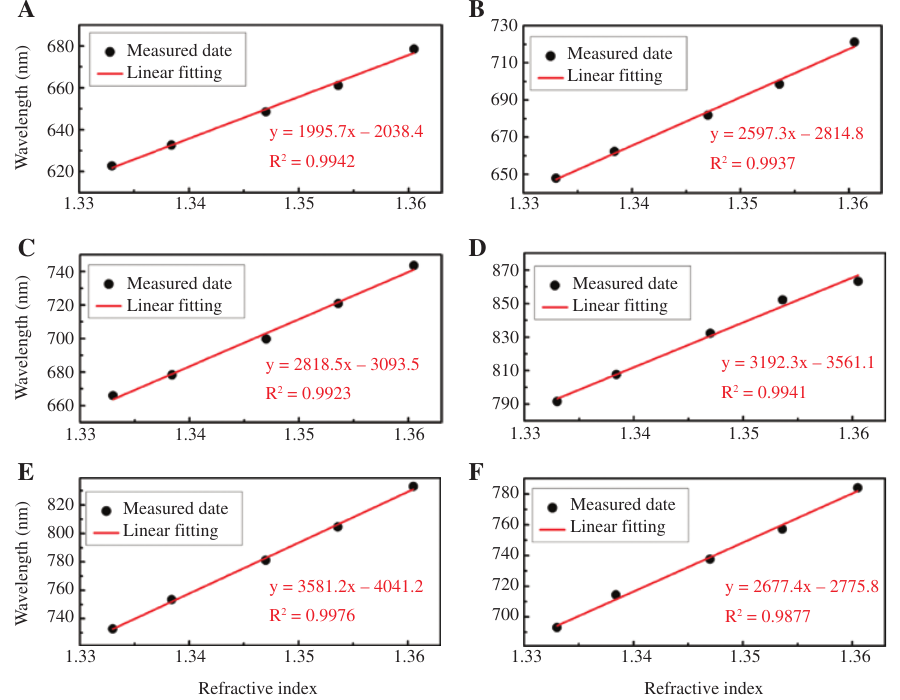
Figure 6: Linear fit curve for the amount of SPR resonant wavelength shift with respect to the refractive index under the condition of different GeSe nanosheets thickness. (A) without spinning coating; (B) one; (C) two; (D) three; (E) four; (F) five times of spin